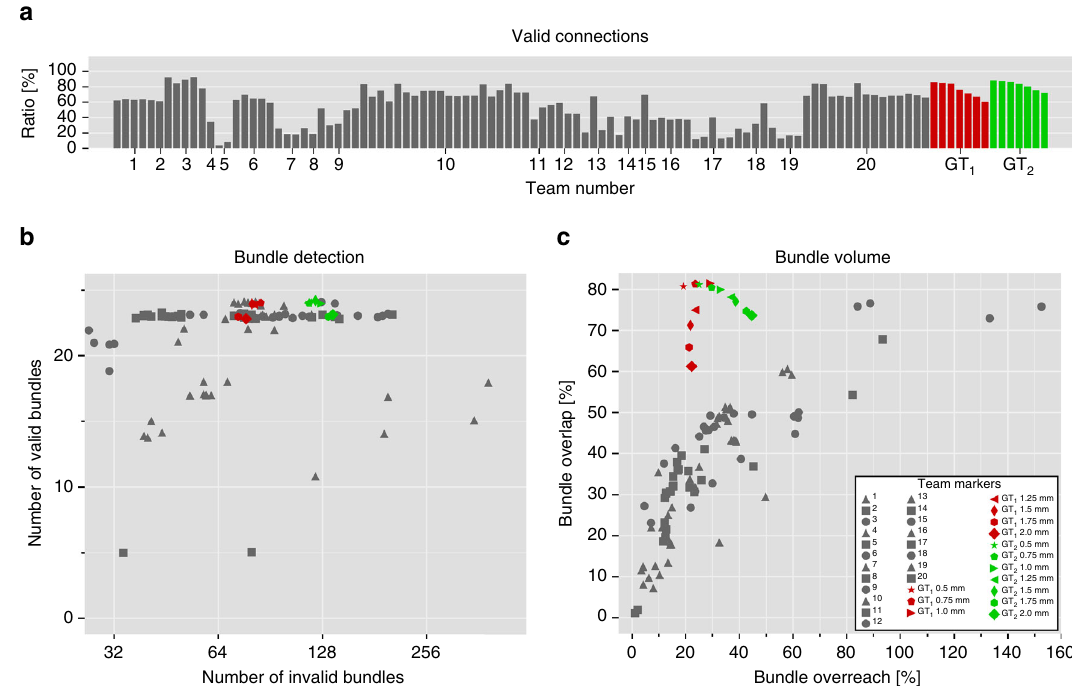
Fig. 6 Tractography on ground truth directions with no noise still affected by IB problem. We applied deterministic tractography directly to the ground truth vector fi eld with multiple resolutions (2, 1.75, 1.5, 1.25, 1.0, 0.75, and 0.5 mm). Two independent implementations of deterministic tractography methods were used to obtain the results (GT 1 and GT 2 , cf. Supplementary Note 2). a Percentage of streamlines connecting valid regions. b Number of detected VBs and IBs (data points are jittered to improve legibility). c Volume overlap and overreach scores averaged over